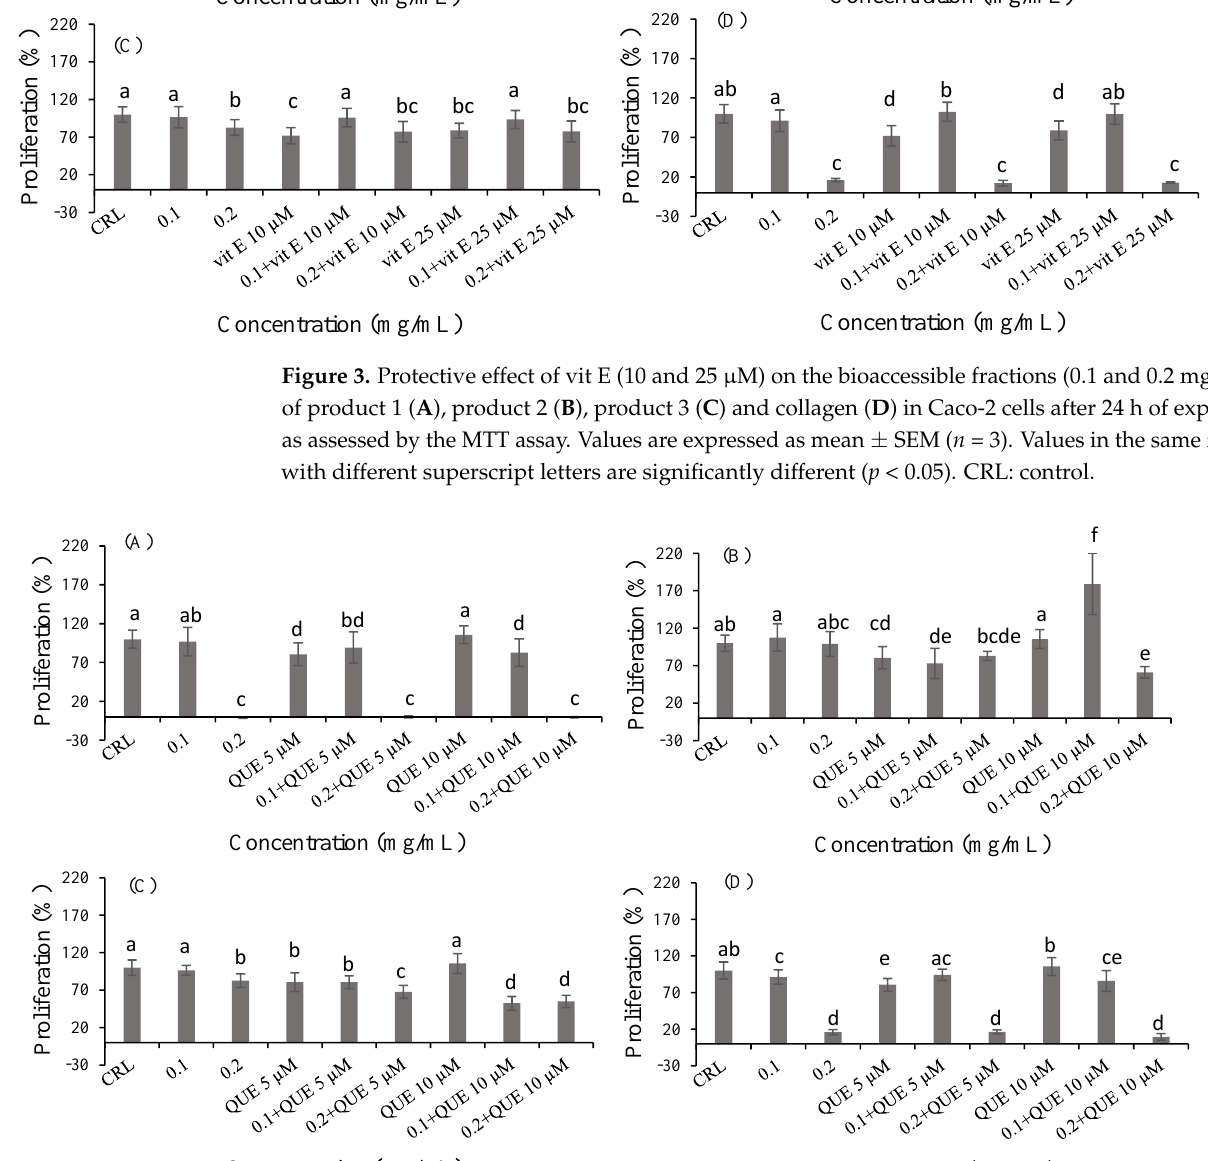
Figure 4. Protective effect of QUE (5 and 10 µM) on the bioaccessible fractions (0.1 and 0.2 mg/mL) of product 1 ( A ), product 2 ( B ), product 3 ( C ) and collagen ( D ) in Caco-2 cells after 24 h of exposure as assessed by the MTT assay. Values are expressed as mean ± SEM ( n = 3). Values in the same figure with different superscript letters are significantly different ( p < 0.05). CRL: control; QUE: quercetin.